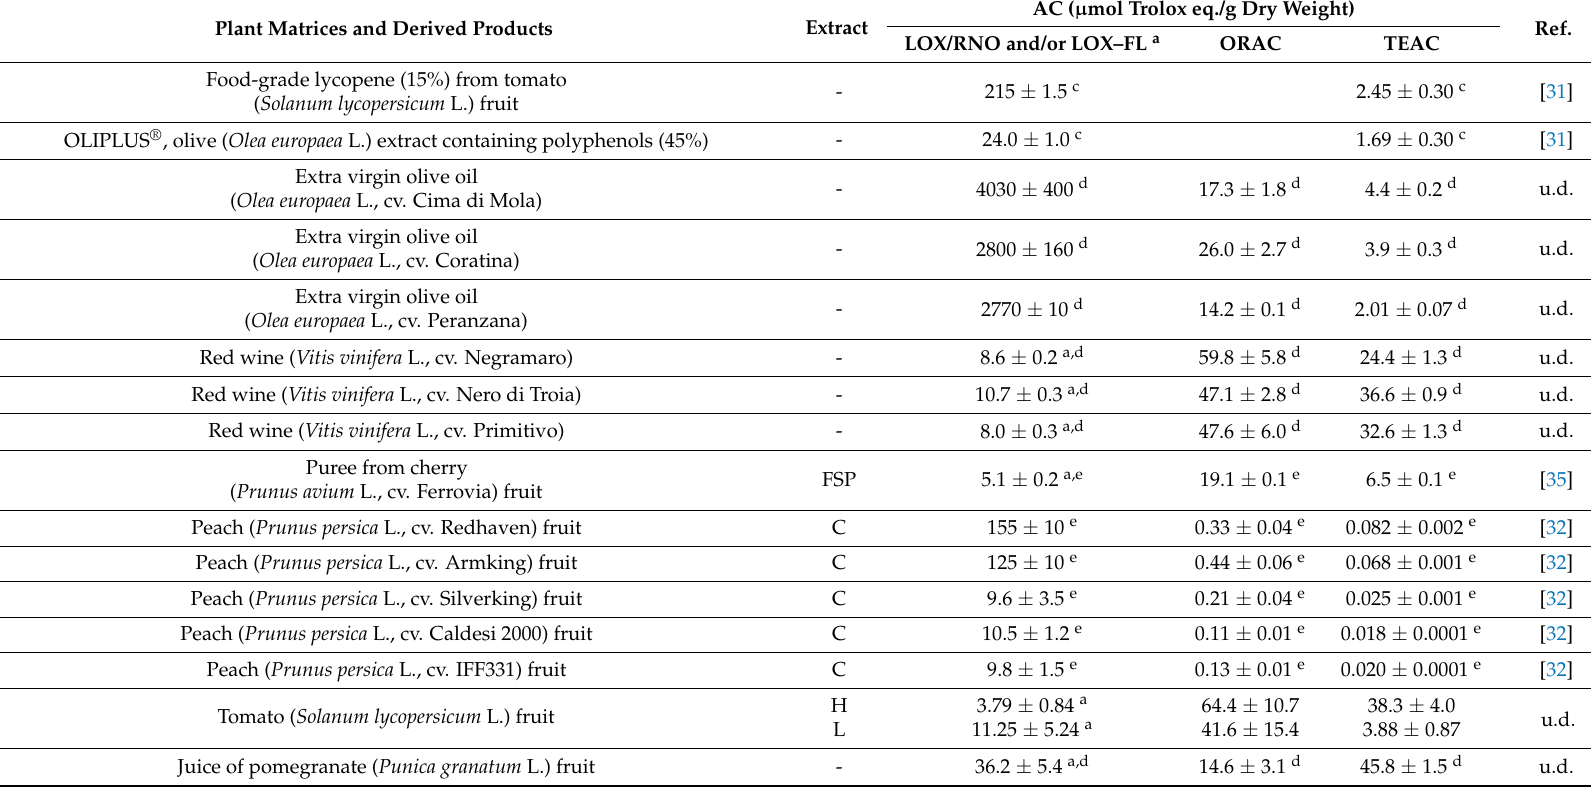
Plant Matrices and Derived